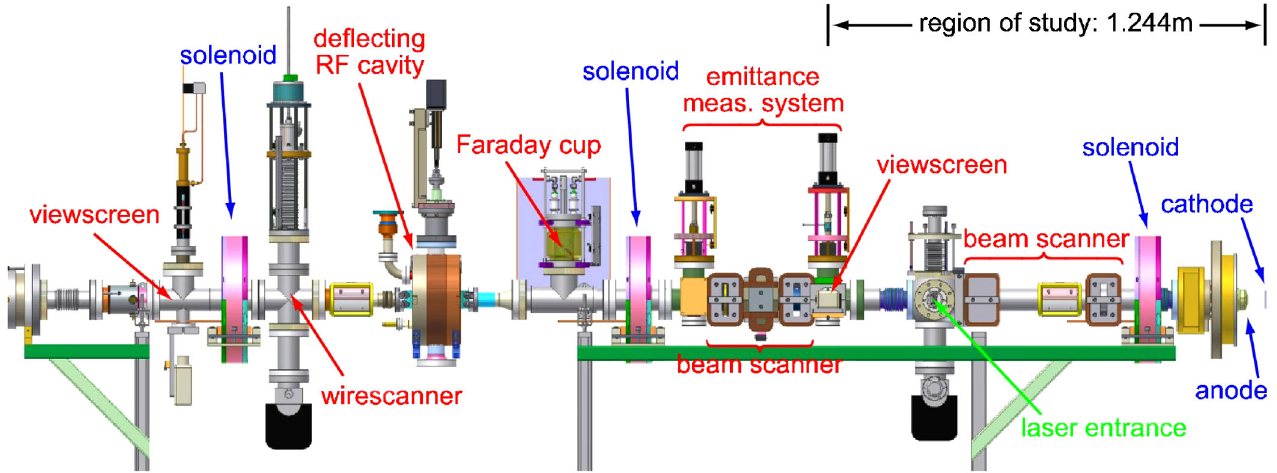
FIG. 1. (Color) The beam line used in the space charge studies. Beam direction is to the left.